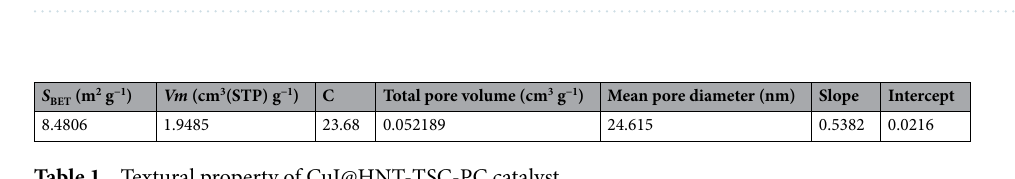
Figure 6. The N 2 adsorption–desorption isotherm of CuI@HNT-TSC-PC. ADS adsorption, DES desorption.